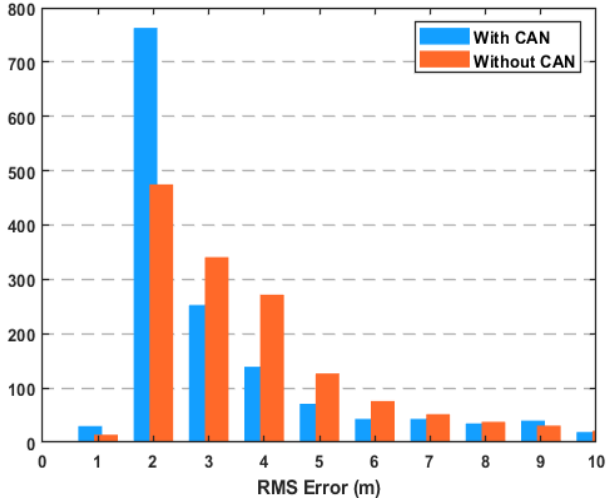
Figure 9. GNSS performance in terms of the RMS error at P3 with and without CAN.